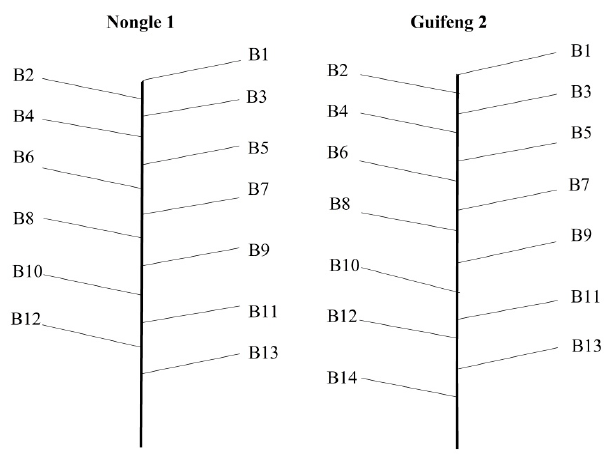
Figure 2. Thirteen primary branch grains of Nongle 1 panicle and fourteen primary branch grains of Guifeng 2 panicle. B1 to B14 represent the grains from the top 1st primary branch to the basal 14th primary branch on rice panicles for Nongle 1 and Guifeng 2.